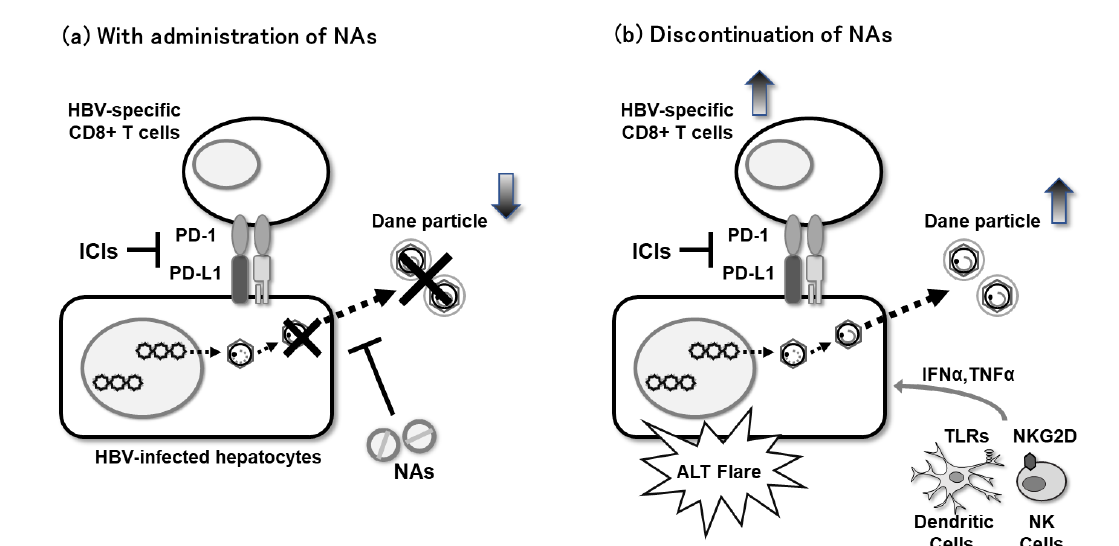
Figure 2. T cell responses during NAs administration. ( a ) With administration of NAs, HBV-specific CD8 + T cells remain unchanged, and ALT does not increase. ( b ) Without administration of NAs, HBV-specific CD8 + T cells are activated and ALT increases. Upward gradient arrows indicate an increase and downward gradient arrows indicate a decrease. ICIs, Immune checkpoint inhibitors .